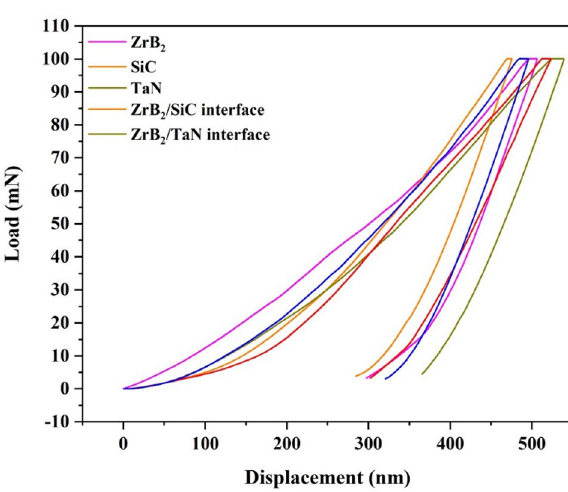
Figure 8. Nanoindentation results of ZrB 2 -SiC-TaN ceramic.